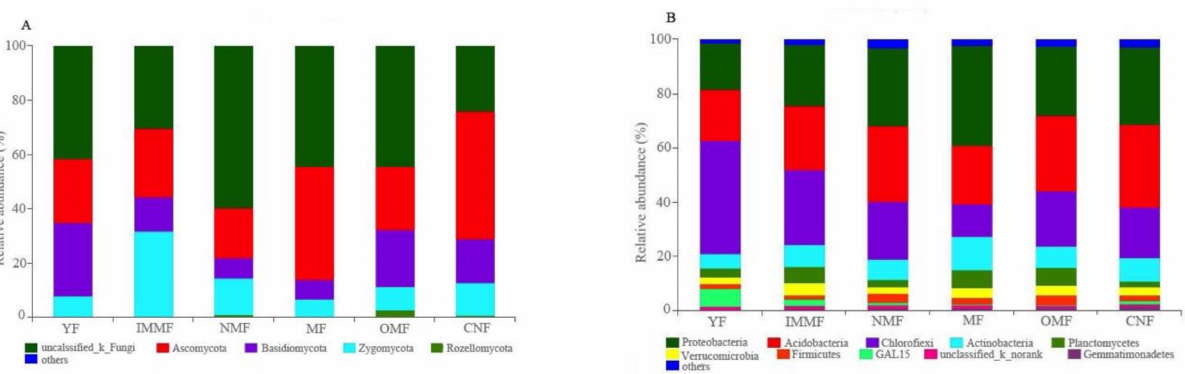
Figure 5. Stacked vertical bars depicting the relative abundance of the taxa present at different stands. Colors in the stacked vertical bars correspond to the phylum level classification of each taxon; taxa accounting for less than 1% of the total number of sequences are depicted in “others”. ( A ) fungi, ( B )